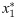
Decryption key sensitivity showed by Lena.(a) Decrypted image of Lena’s cipher; (b) Decrypted image of Lena’s cipher with key x1* changed 10−15.